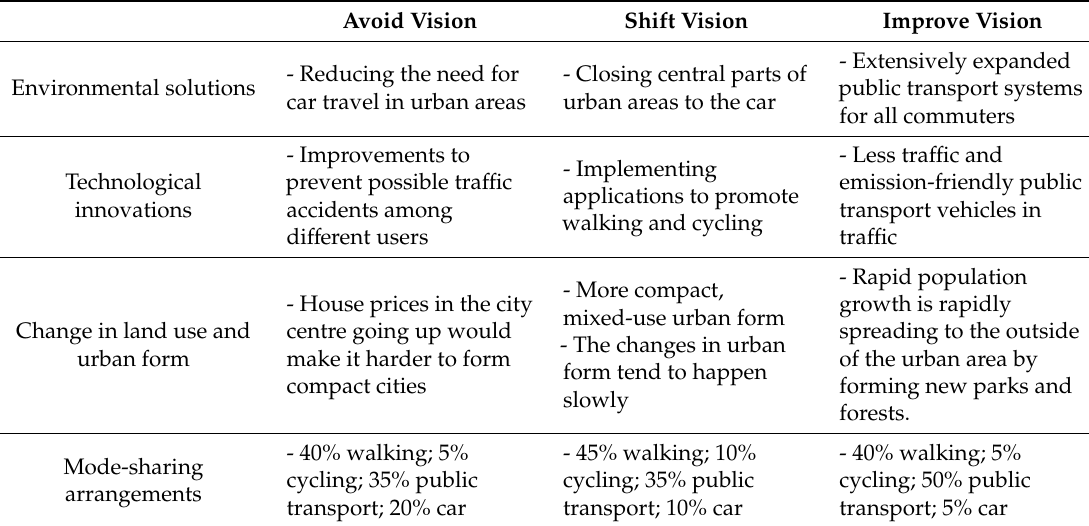
Table 3. Summary of 2035 visions for Turkish urban